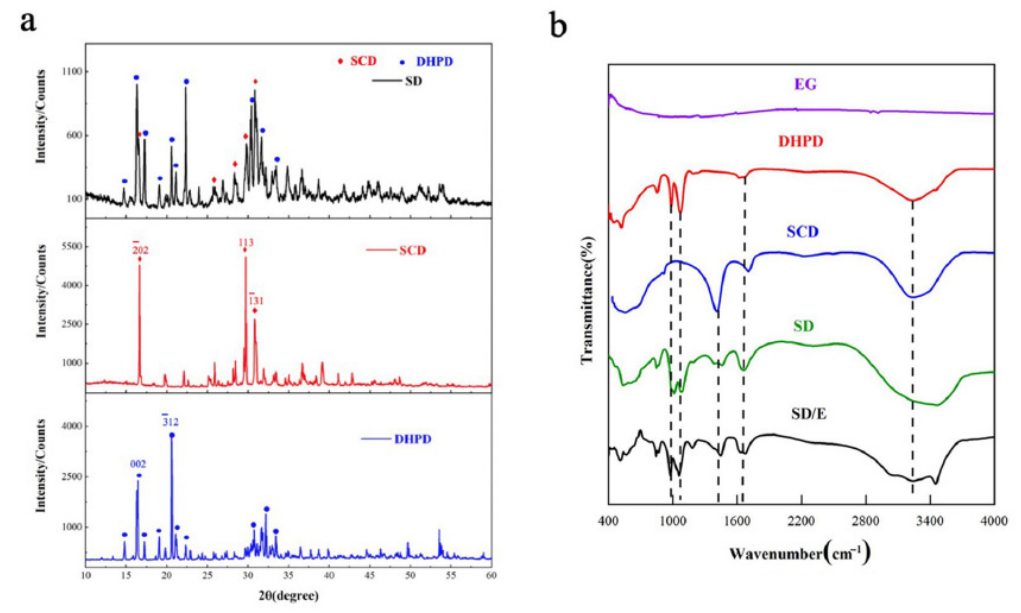
Figure 2. ( a ). XRD patterns of disodium hydrogen phosphate dodecahydrate (DHPD), sodium carbonate decahydrate (SCD), and SD; ( b ). FT-IR spectra of expanded graphite (EG), DHPD, SCD, SD, and SD/E.